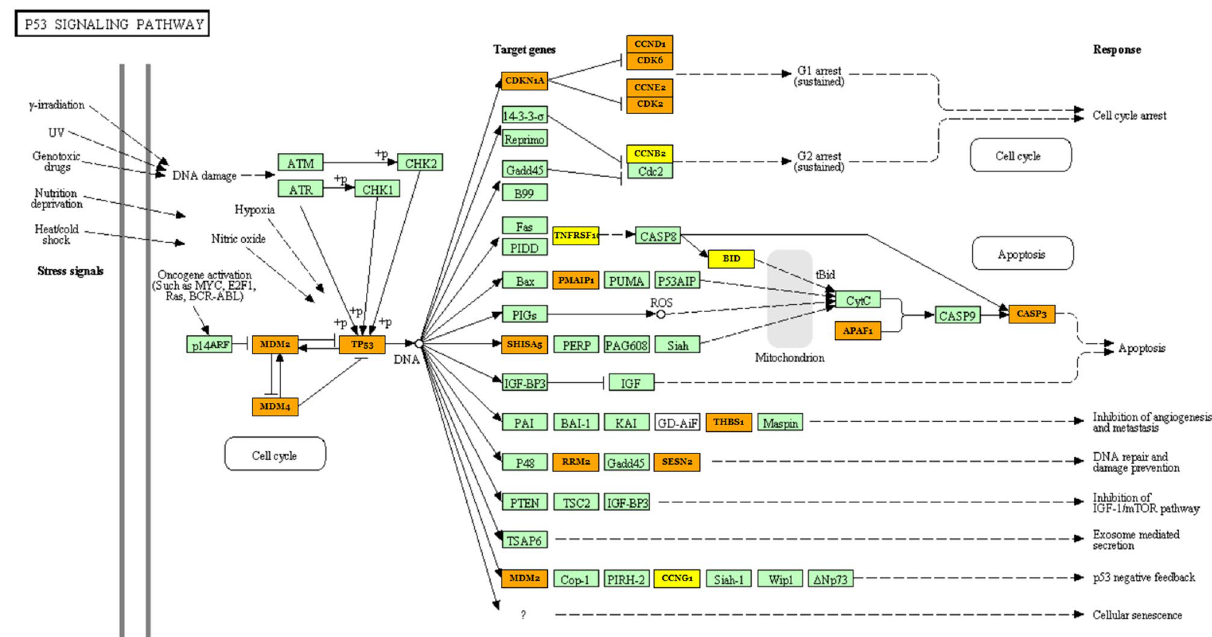
Figure 7. Pathway and targets prediction. The figure shows the associations between let-7a and let-7f ecmiRNAs and their putative p53 signaling pathway (p-value 0.0027432, and 23 gene interactions). The server offers two-gene labeling levels: yellow (gene targeted by 1 selected miRNA, let-7a), orange (gene targeted by 2 selected ecmiRNAs, let-7a and let-7f). Green color indicates genes that are not targeted by let-7a and let-7f Pathways analysis was performed using DIANA-miRPath